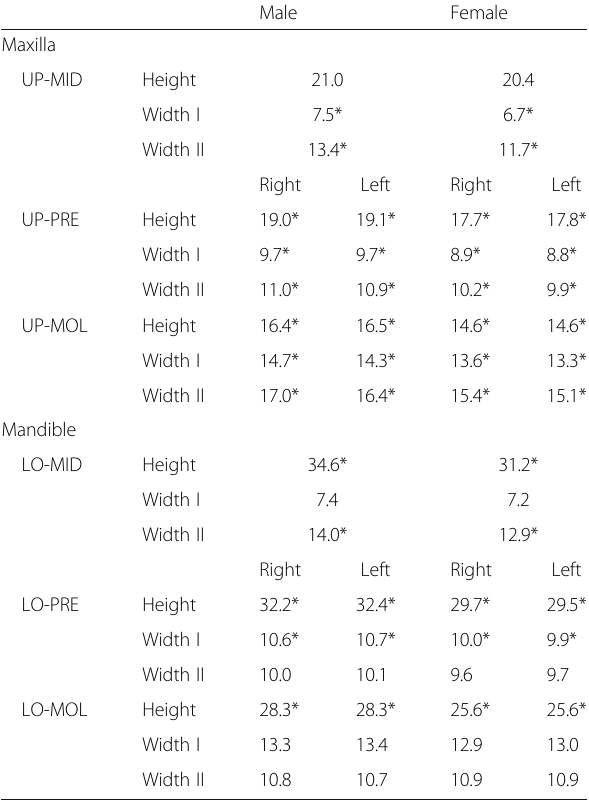
Table 3 Difference between male and female when comparing measurements of jaw bone height and width in millimeters